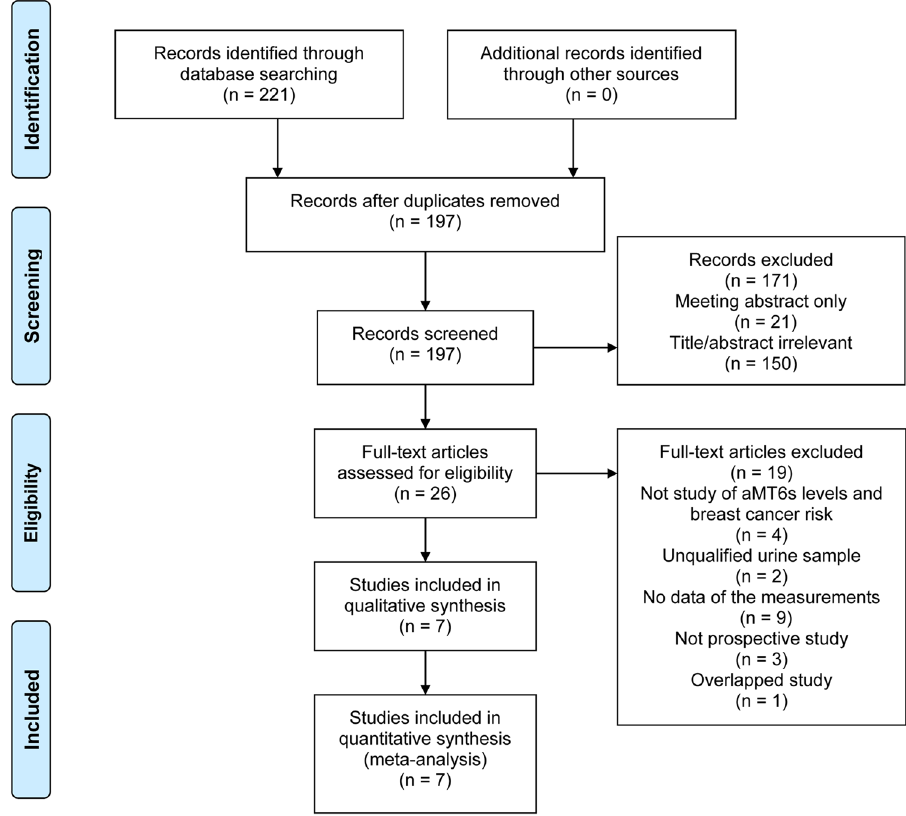
Figure 1. Literature retrieval flow diagram. aMT6s,